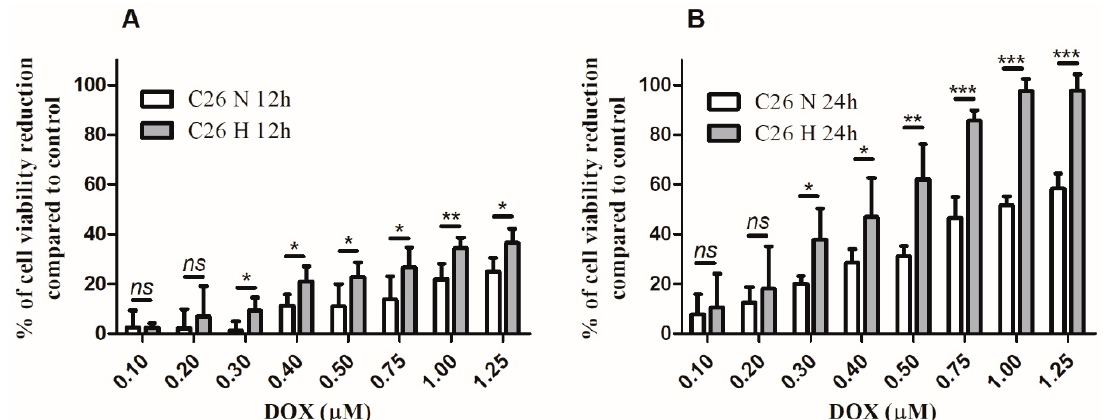
Figure 1. The e ff ects of doxorubicin (DOX) on C26 murine colon carcinoma cells under normoxic and hypoxic conditions. ( A ) Percentage of cell viability reduction compared to the viability of control untreated cells after 12 h incubation of C26 cells with increasing concentrations of DOX ranging from 0.1 µ M to 1.25 µ M under either normoxia (C26 N 12 h) or hypoxia (C26 H 12 h). ( B ) Percentage of cell viability reduction compared to the viability of control cells after 24 h incubation of C26 cells with increasing concentrations of DOX ranging from 0.1 µ M to 1.25 µ M under either normoxia (C26 N 24 h) or hypoxia (C26 H 24 h). Data are shown as mean ± SD of triplicate measurements of two independent experiments; ns : not significant, p > 0.05; *, p < 0.05; **, p < 0.01; ***, p < 0.001. Table 1. Hypoxia cytotoxicity ratio (HCR) and mean values of IC 50 of DOX after 12h and 24h incubation of C26 colon carcinoma cells with the drug under normoxia and hypoxia. 12 h Drug Treatment